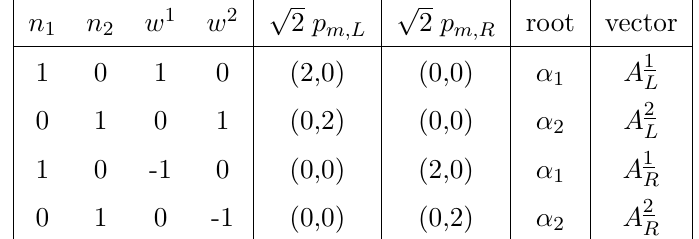
Figure 2 . Enhancement groups on the domain (cid:28) = (cid:26) . The groups SU(3) L (cid:2) SU(3) R and SU(2) 2 SU(2) 2 occur at the isolated points on the left and right vertices, respectively, while [SU(2) (cid:2) R U(1)] L (cid:2) [SU(2) (cid:2) U(1)] R occurs along the boundaries.